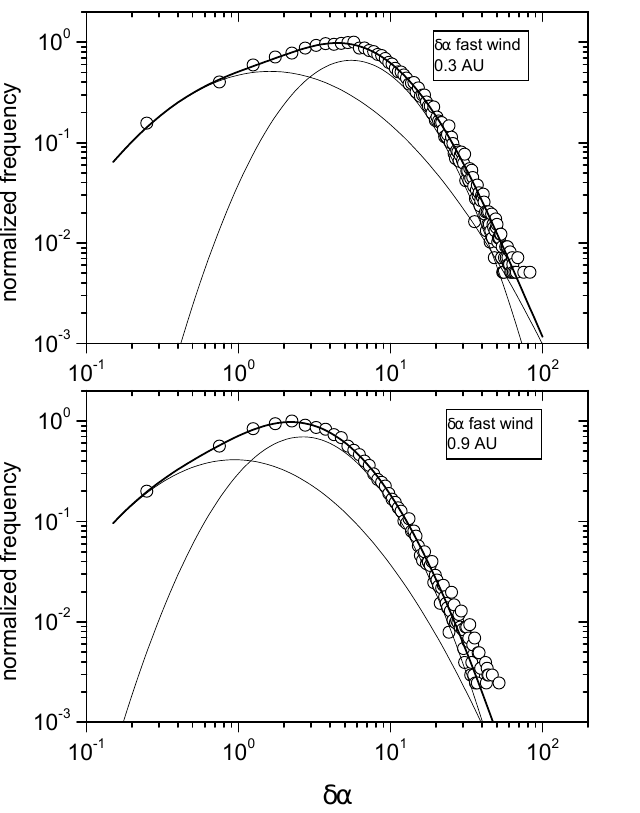
Fig. 10. PDFs of vector displacements | δB | normalized to σ at 0.3 and 0.9AU, for a slow wind, are shown in the top and bottom panels, respectively. The two thin solid curves refer to as many lognormals contributing to form the thick solid curve which best fits the distribution. Parameters relative to the fit are reported in Table